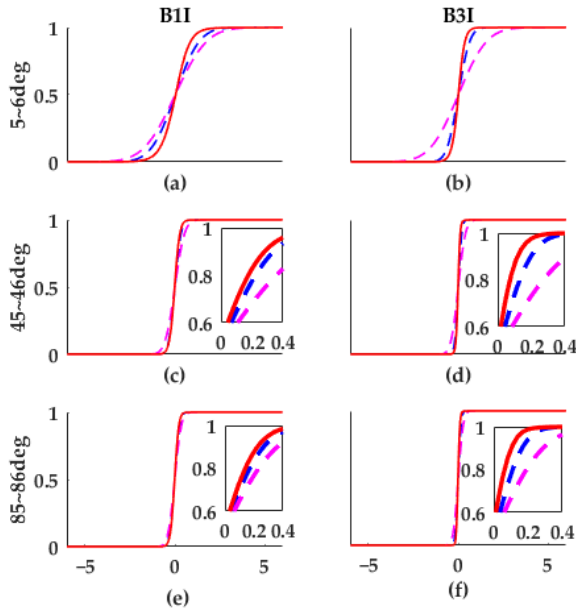
Figure 7. CDF of constructed models and multipath error. The sub-figures ( a , c , e ) are results of B1I and ( b , d , f ) are results of B3I, respectively. The red lines are CDF of actual multipath error, the dashed blue lines are that of constructed models based on two inflation factors, and the dashed magenta lines are that of constructed models based on single inflation factor.